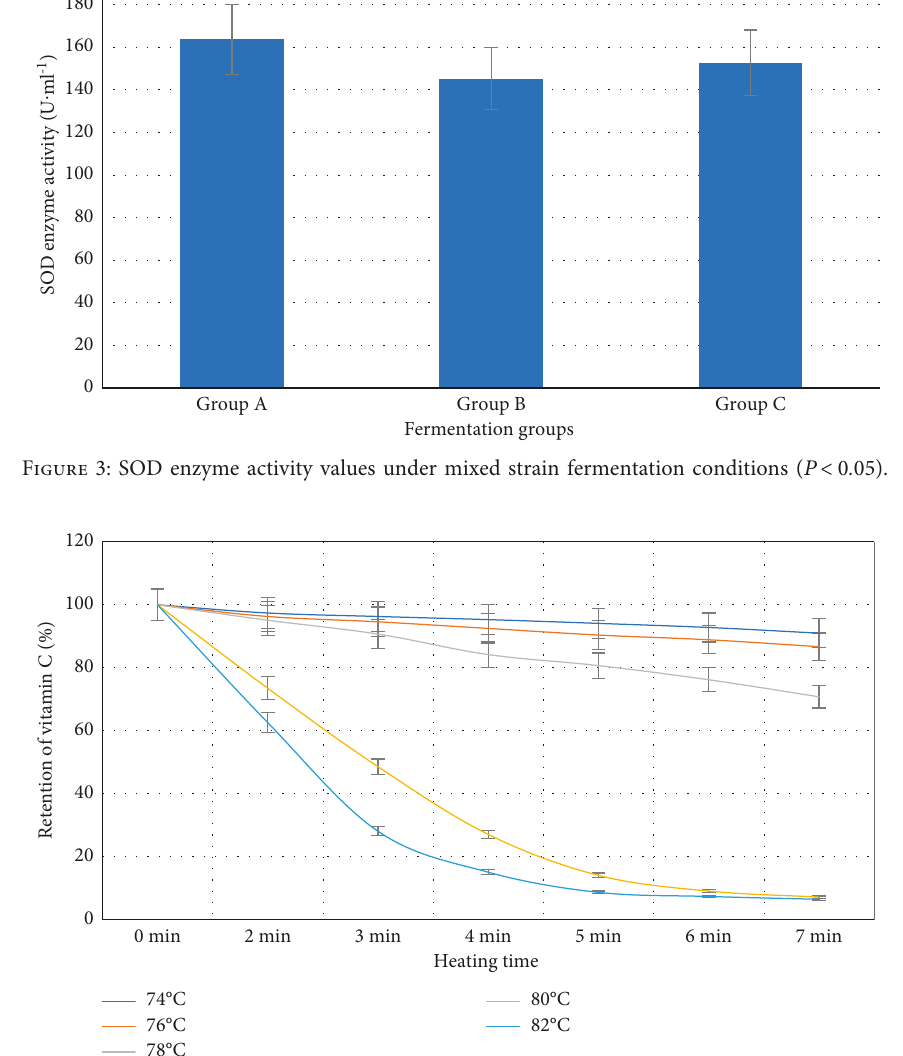
Figure 4: Variation of vitamin C retention with time at different heating temperatures.